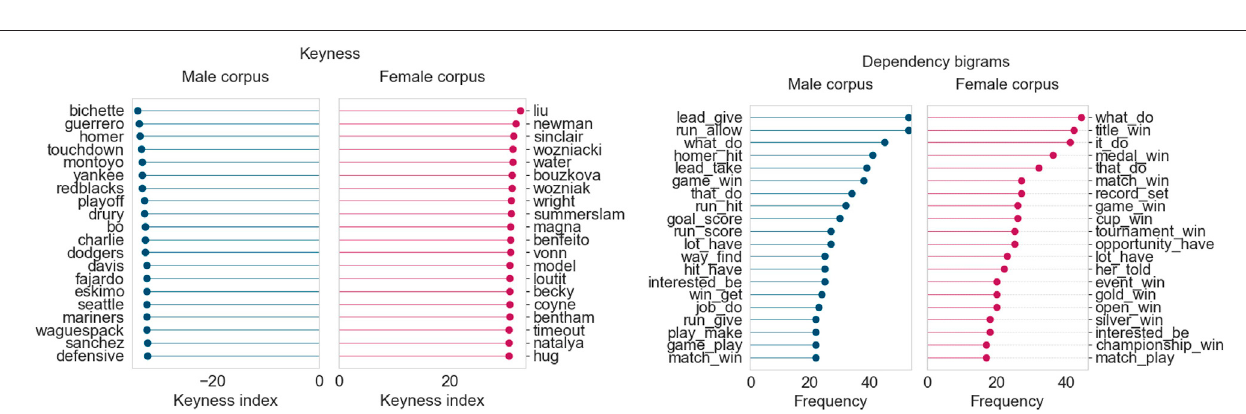
FIGURE 6 | Corpus analysis results for top 200 articles from “ Sports ” (August